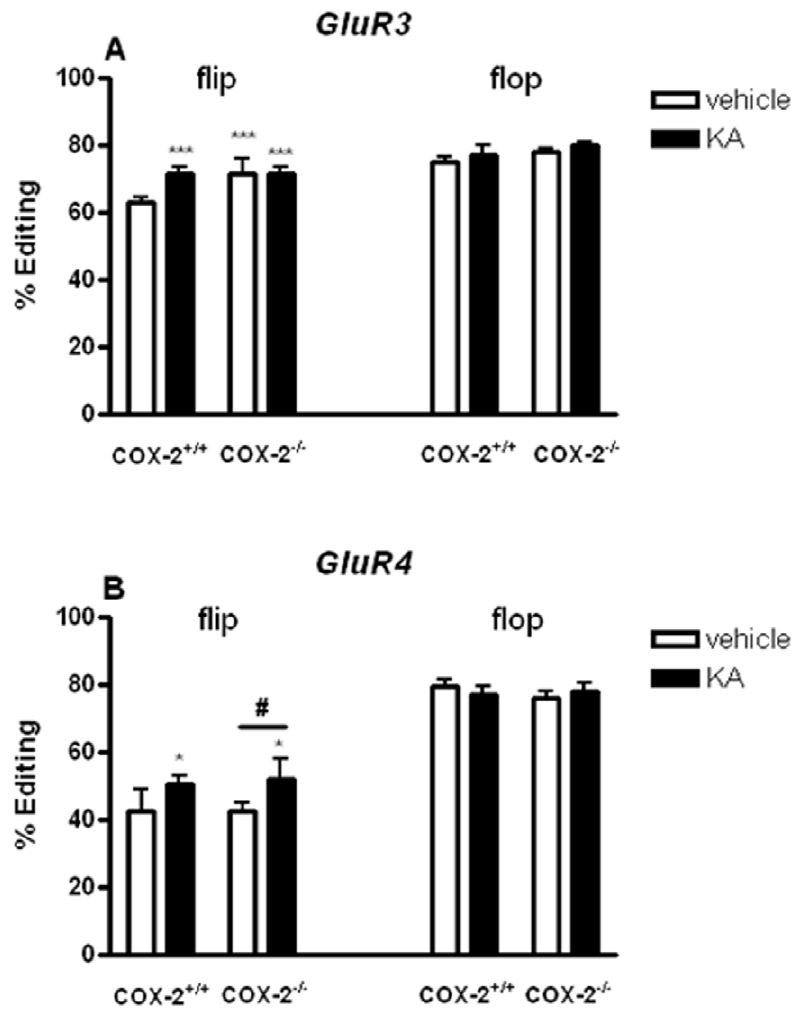
Figure 9. KA-induced editing of AMPA editing site glutamate receptor subunits in the hippocampus of COX-2 + / + and COX-2 2 / 2 mice. Evaluation of RNA editing levels of the AMPA glutamate receptors in the hippocampus of mice injected with KA. (A) GluR3 R/G site flip- flop- variant and (B) GluR4 R/G flip- flop-variant, editing site. Data are presented as mean 6 SEM (n=6). Statistical analysis was performed with Student’s t test (*P , 0.05, **P , 0.01, ***P ,